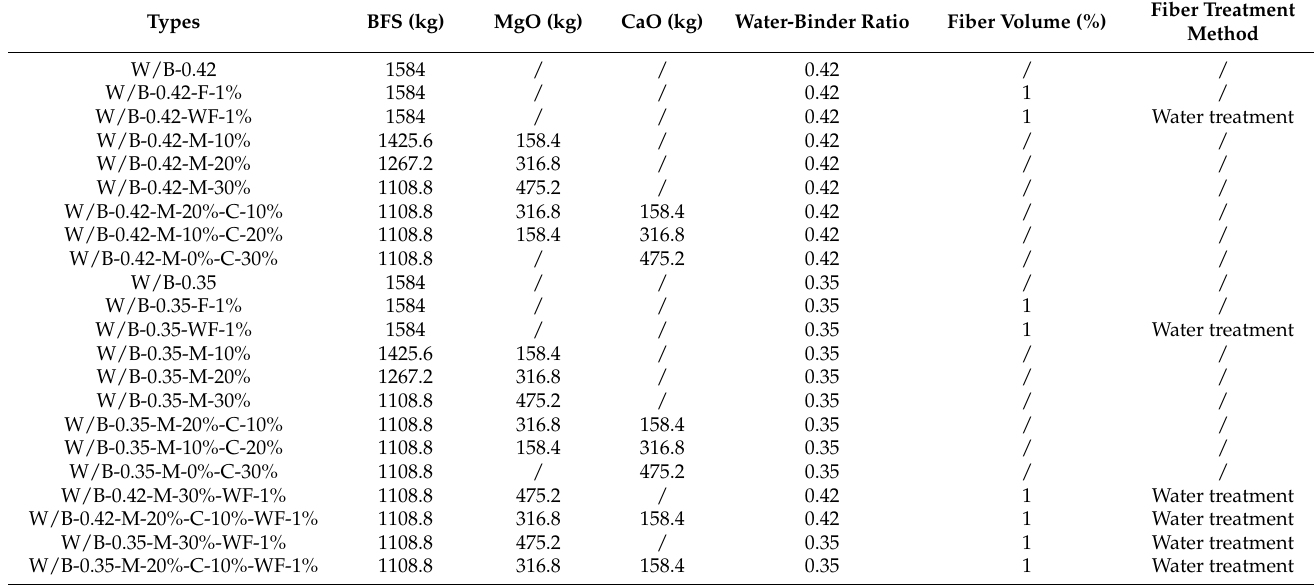
Table 2. The mixing proportions of alkali-activated blast furnace slag